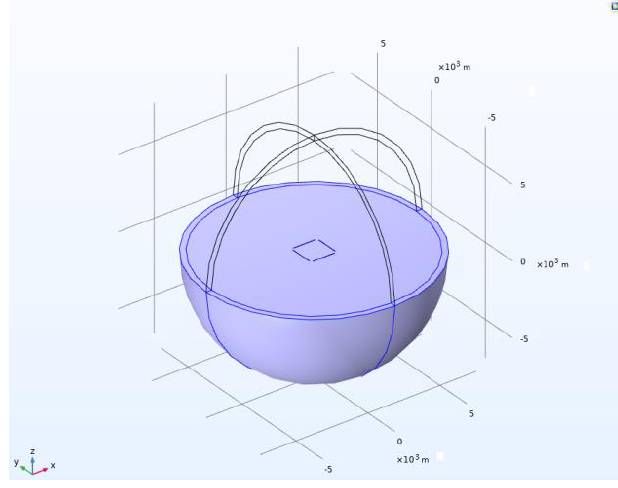
Figure 13. The SRE CP MD antenna array radiation source model.